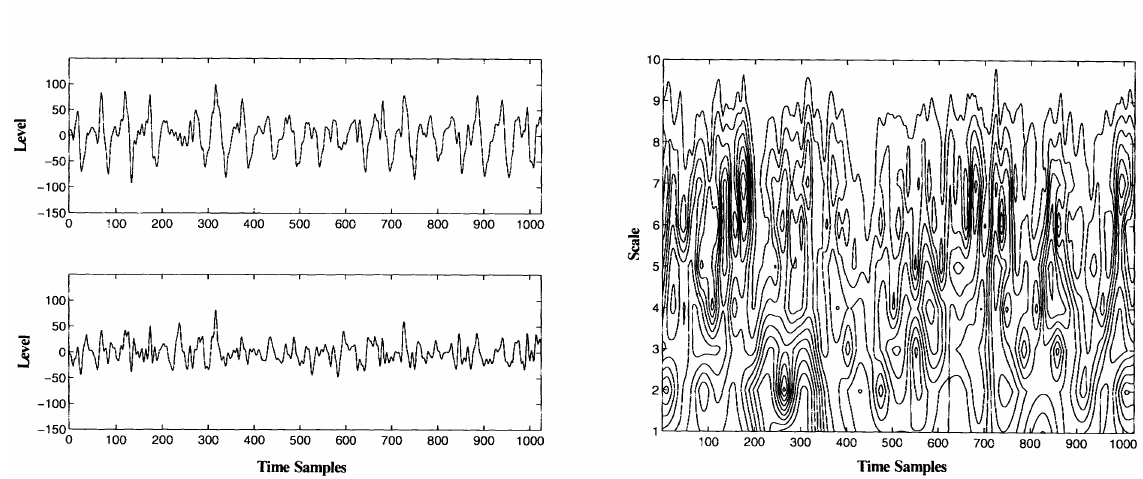
FIGURE 3 Synchronous averaged vibration and its residual.